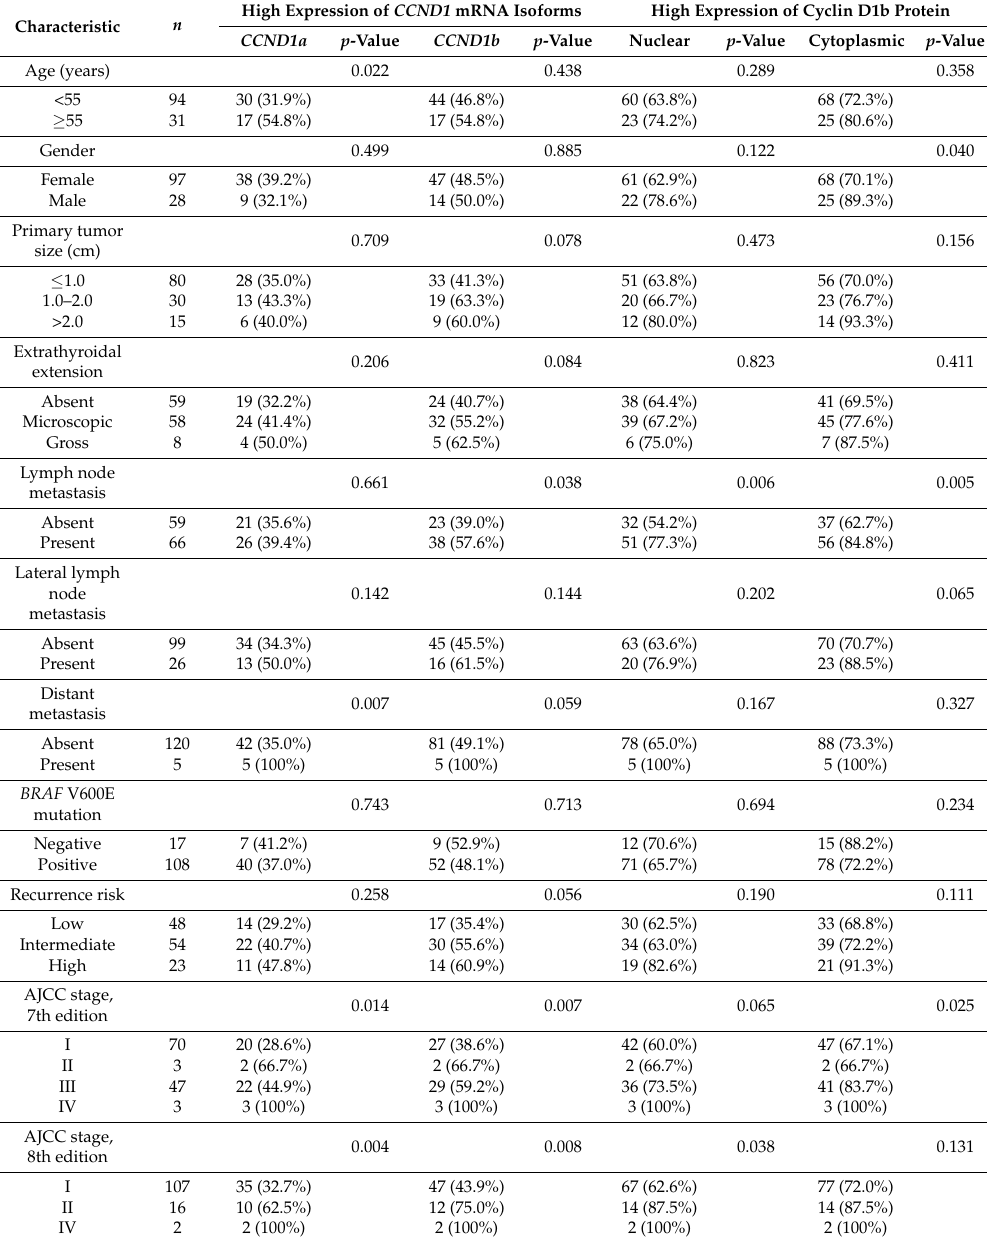
Table 3. Correlation between clinicopathologic features and expression of mRNA CCND1 isoforms and cyclin D1b protein in 125 patients with classic variant of papillary thyroid